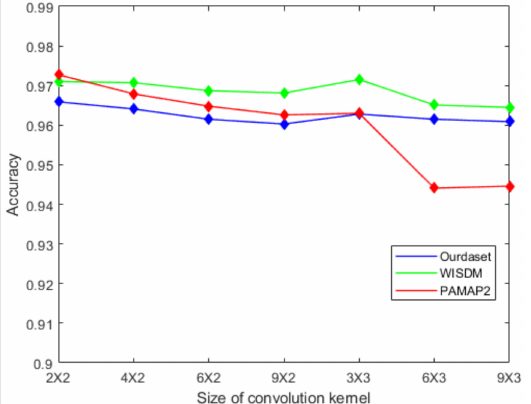
Figure 9. The effect of convolution kernel size on recognition accuracy.